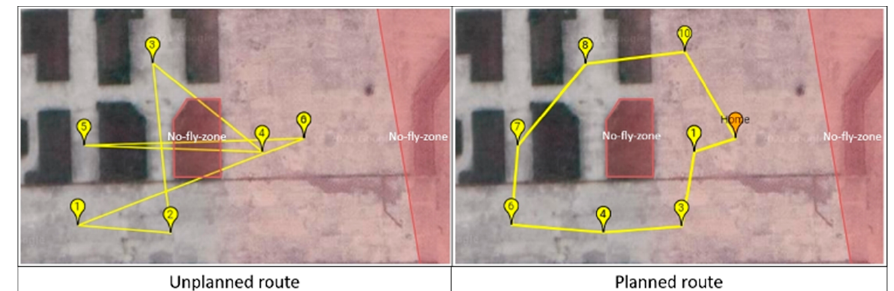
Figure 19. Flight trajectory for the formation flight experiment.